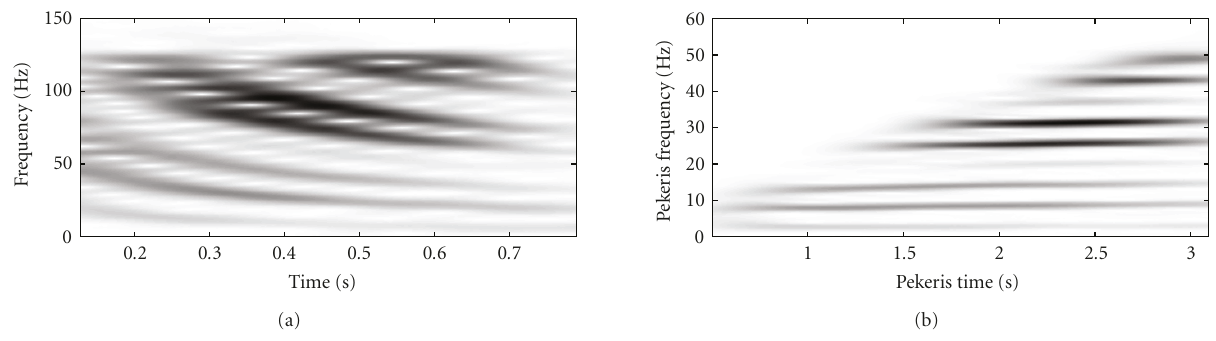
Figure 12: Classical STFT and adapted STFT (matched to Pekeris model) of a signal recorded on a single hydrophone. The simulation is given for the source ULF-1 at 40-m depth and 10 km distant from hydrophone.